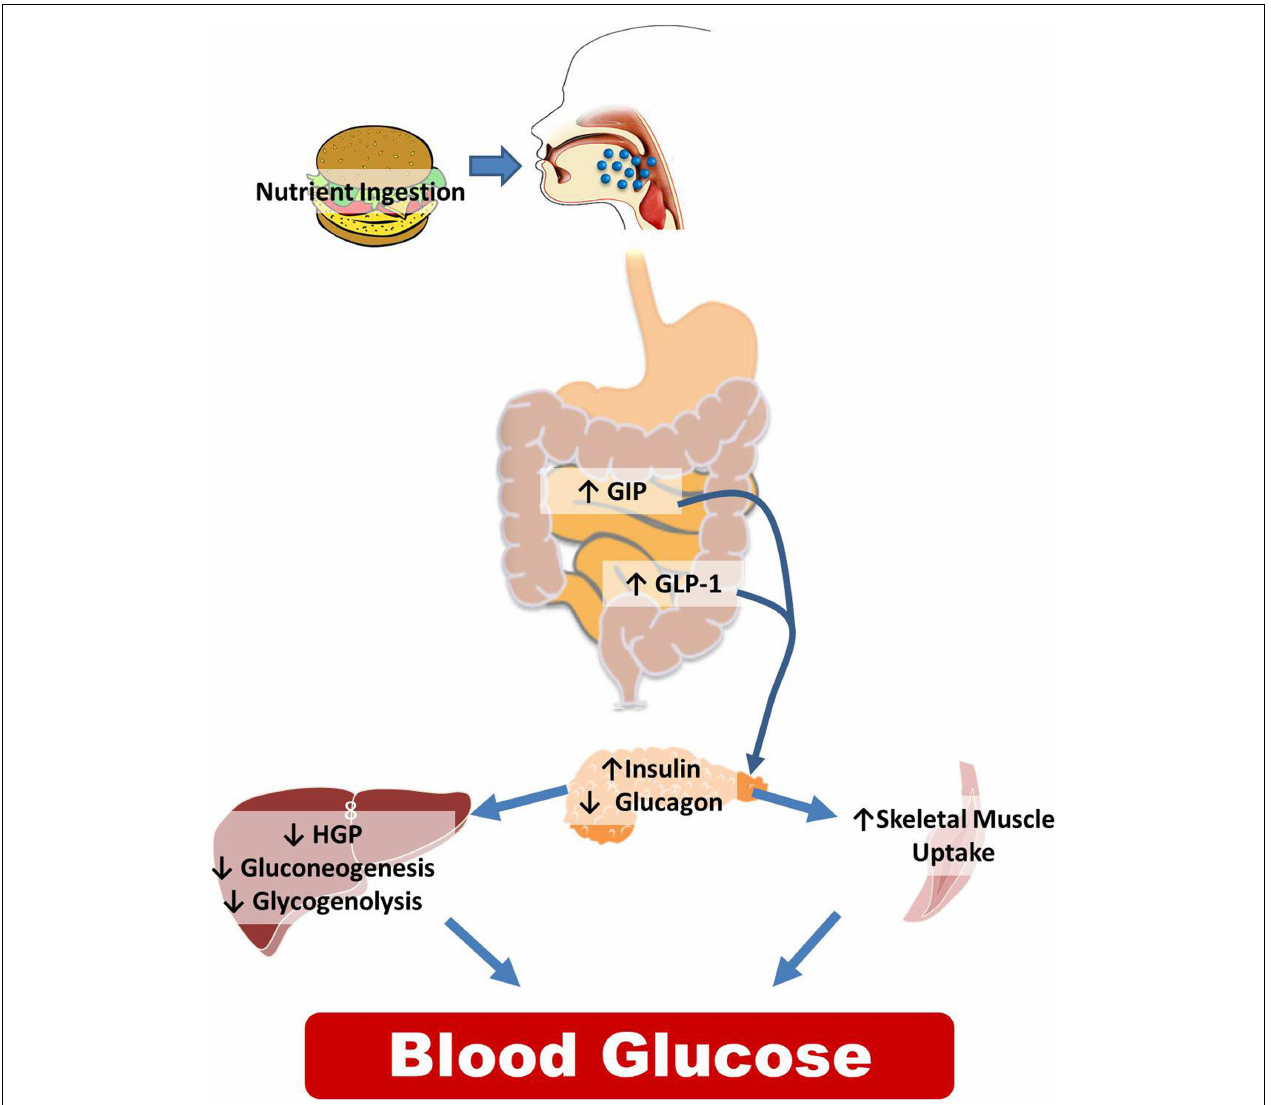
from the pancreas.The role of the intestine in regulating nutrient partitioning is highlighted by the fact that pancreatic β -cell insulin secretion in response to a given glucose load is greater when the glucose is infused into the gut versus when infused intravenously.This is because, incretins, glucose-dependent insulinotropic polypeptide (GIP), and glucagon-like peptide-1 (GLP-1), released from the intestine in a nutrient-dependent manner, act on their receptors located in the β -cell to stimulate the release of insulin. GLP-1 also inhibits glucagon secretion.This change in hormonal milieu, increased insulin, and decreased glucagon levels, have a potent impact on suppressing hepatic glucose production (HGP), and favoring peripheral glucose uptake effectively limiting postprandial glycemic